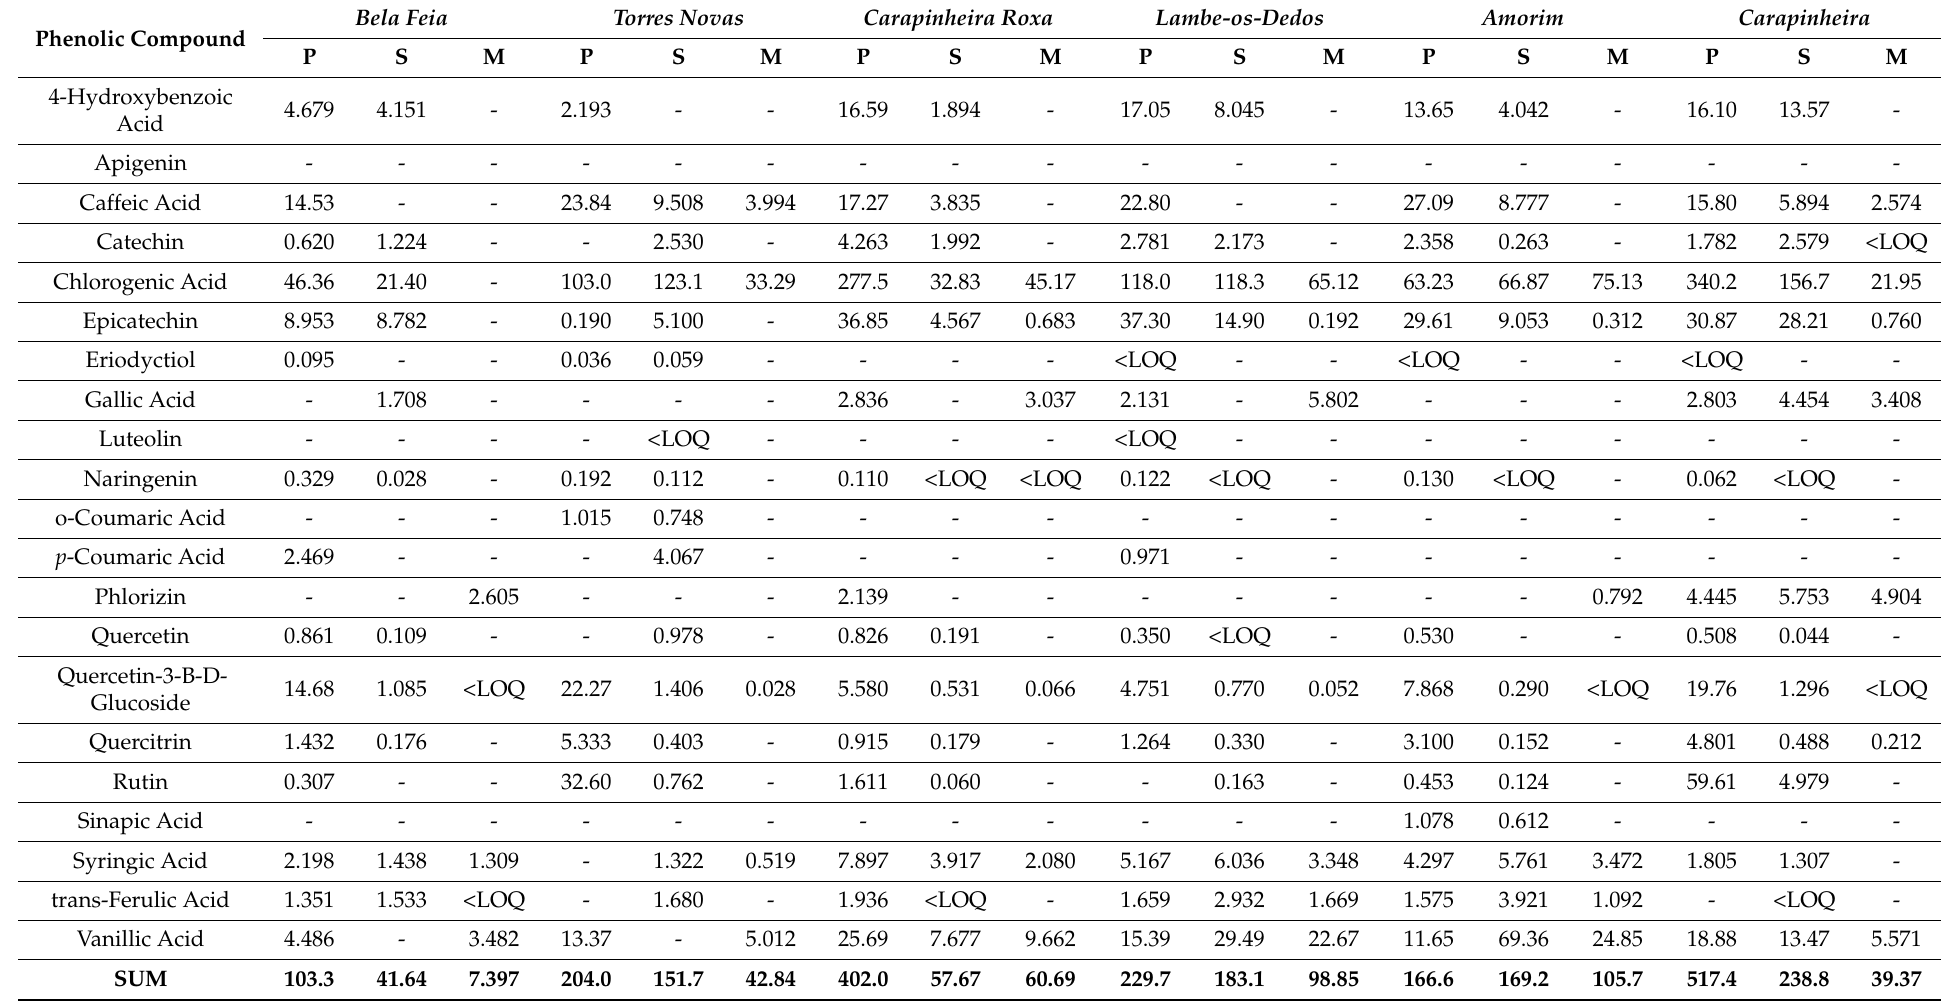
Table 10. Phenolic compounds ( µ g/g FW) in different parts of pear regional cultivars (P: Peel, S: Seed, M: Mesocarp